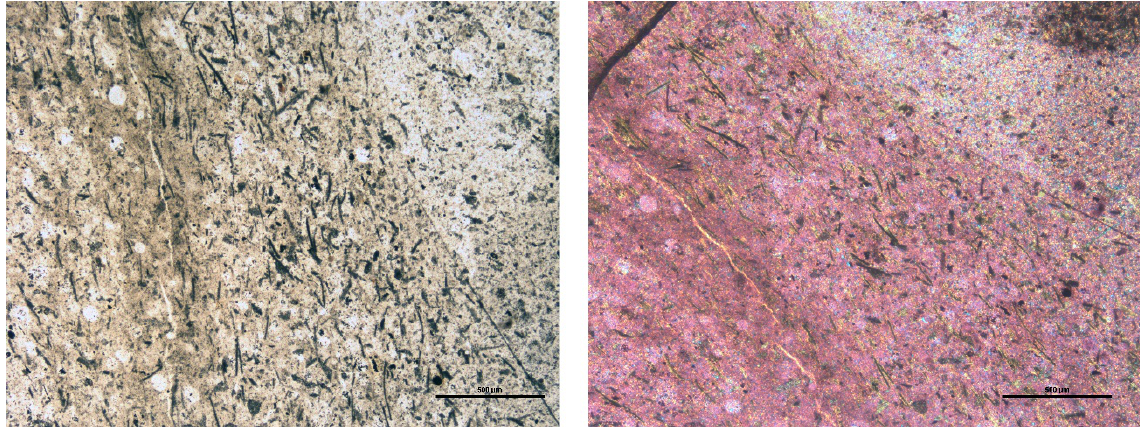
Figure 13. View of the petrographic analysis of the grey flint variety. (Parallel, left/crossed right polariser.) Scale bars are 500 μm wide.